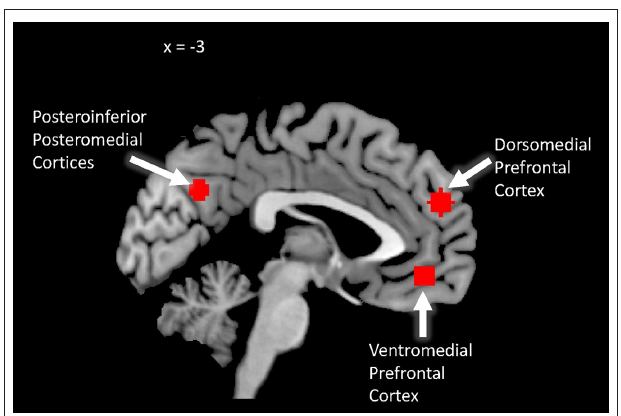
FIGURE 1 | Default mode network region of interest map. Sagittal view of regions of interest in the default mode network derived from whole-brain neural correlates of a verbal measure of cognitive processing previously shown to relate to DMN activity ( Yang et al., 2018; see also Gotlieb et al, in Preparation). Each circle represents a 6mm spherical